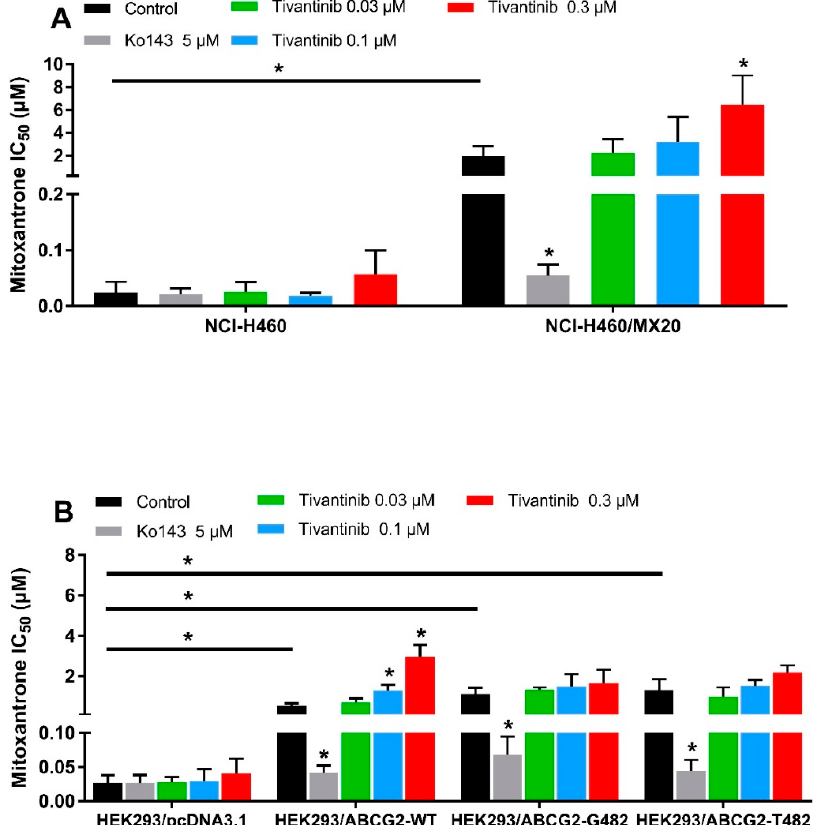
Figure 3. Tivantinib attenuated the cytotoxicity of mitoxantrone in parental and ABCG2- overexpressing cells. ( A ) IC 50 values of mitoxantrone in parental NCI-H460 and drug-selected ABCG2-overexpressing NCI-H460/MX20 cells with or without treatment of tivantinib; ( B ) IC 50 values of mitoxantrone in parental HEK293/pcDNA3.1 and transfected ABCG2-overexpressing HEK293/ABCG2-WT, HEK293/ABCG2-R482G, and HEK293/ABCG2-R482T cells with or